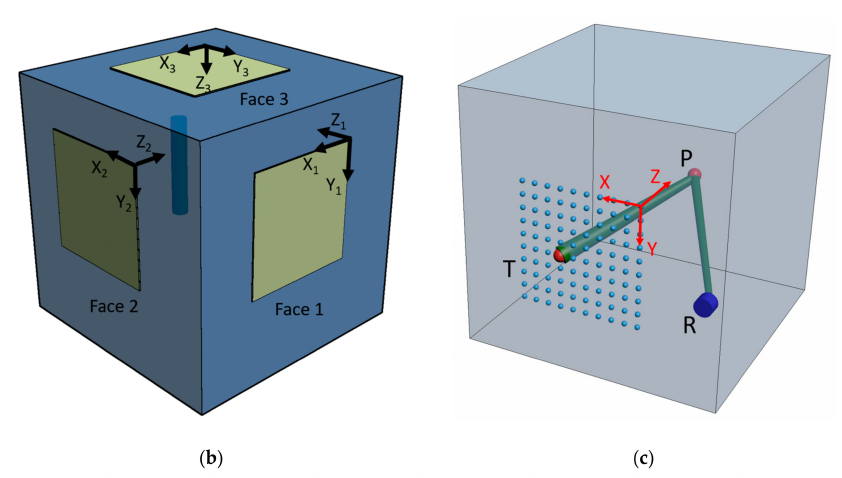
Figure2. ( a )Experimentalsetupusedfortheexcitationanddetectionofultrasoundwaves; ( b )Schematic representation of the object under study with the three-face scan areas. Di ff erent Cartesian axes are represented at each scan face; ( c ) Representation of the 3D object under investigation using the synthetic aperture focusing technique (SAFT) algorithm with the scanning area at one of the faces with the Exciter (T), Receiver (R), and scatterer point in